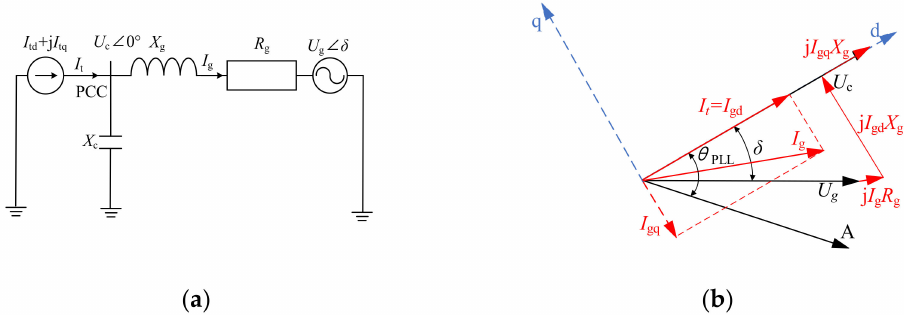
Figure 4. ( a ) Equivalent circuit diagram of a GFL converter; ( b ) phasor diagram of GFL